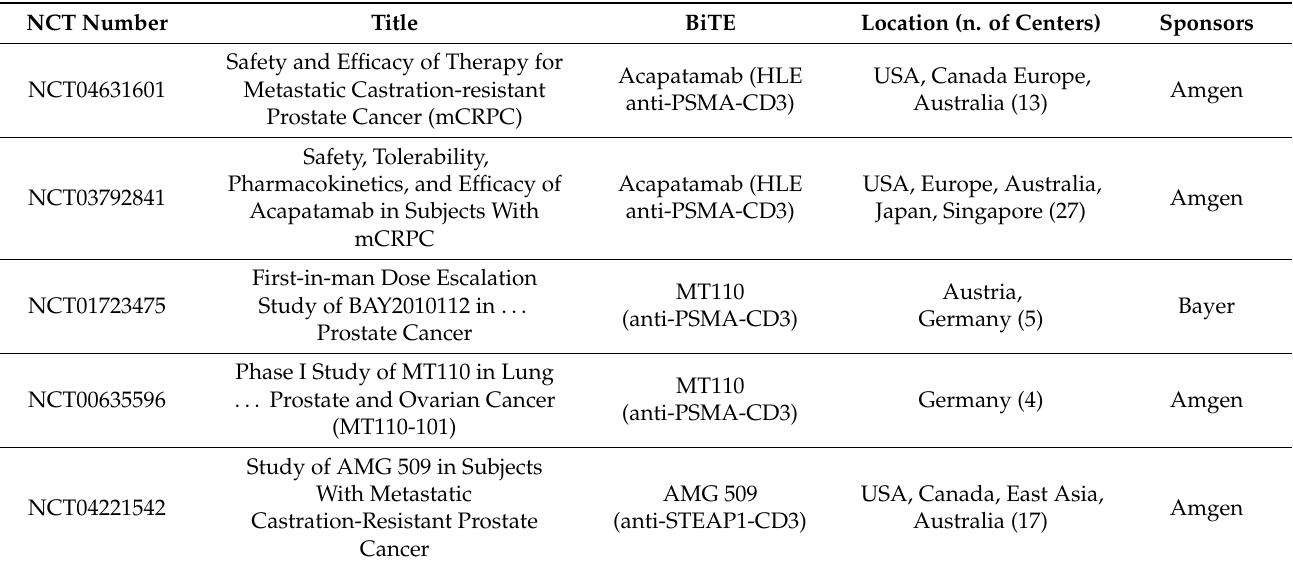
Table 3. Ongoing clinical trials with BITE therapy in metastatic castration-resistant prostate cancer. HLE: half-life extended; PSMA: prostate-specific membrane antigen; STEAP1: six transmembrane epithelial antigen of the prostate